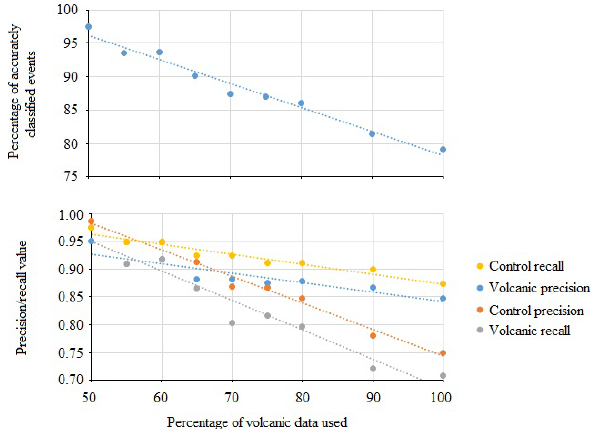
Figure 3. Result of the application of a threshold SO 2 loading to the volcanic dataset on (a) accurately classified events and (b) the precision (no false alerts) and recall (no missed alerts) values for both the volcanic and control datasets.